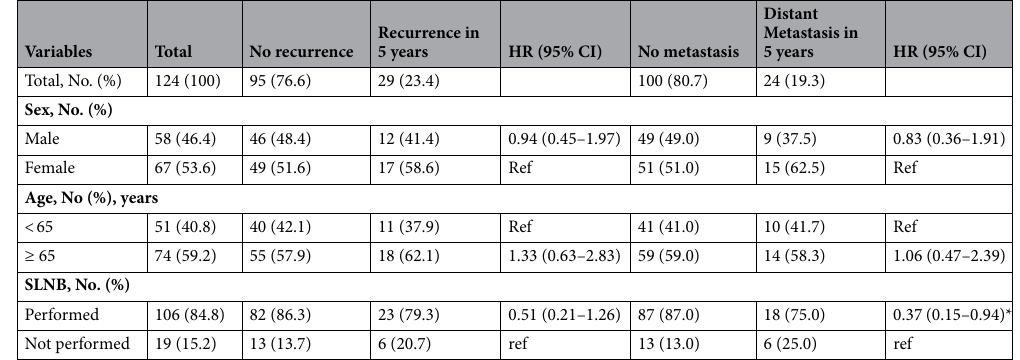
Table 2. Clinical risk factors of recurrence and distant metastases in 5 years among ALM patients. ALM acral lentiginous melanoma, SLNB sentinel lymph node biopsy, HR hazard ratio, CI confidence interval. *Statistically significant with 95% CIs not including